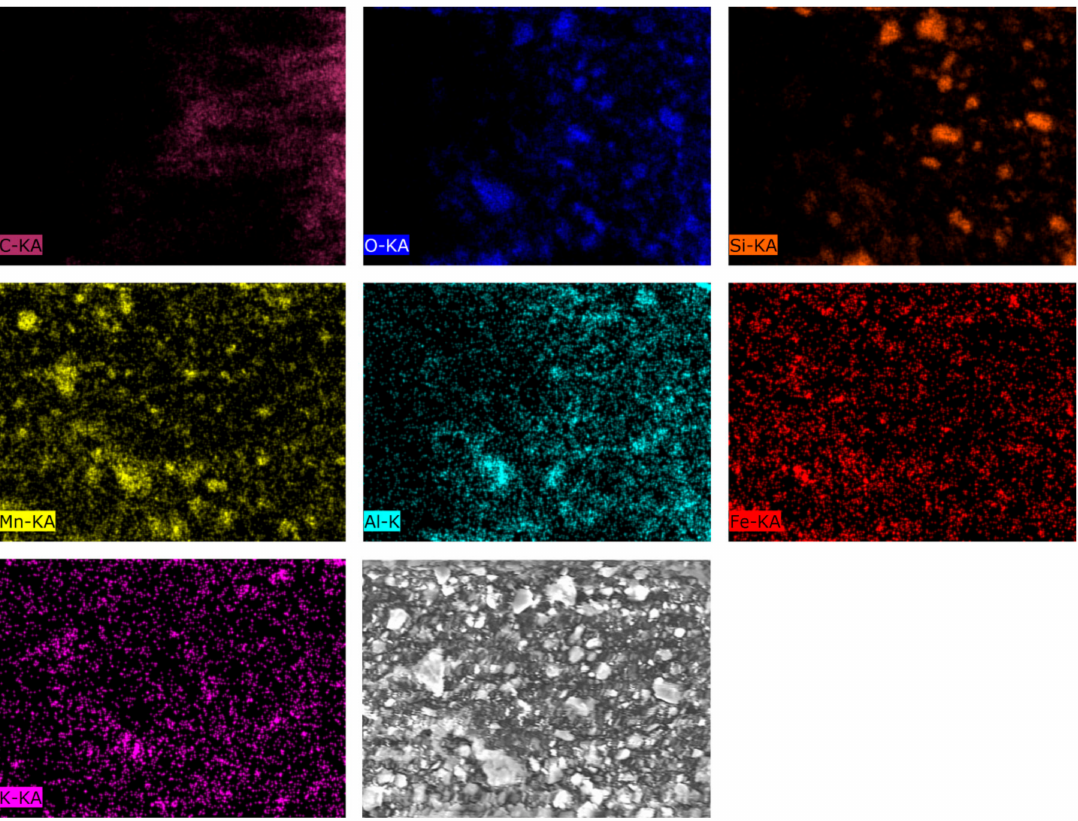
Figure 7. Micrographs with mapping of the distribution of elements on the focused surface of the manganese ore sample from the Zhaksy